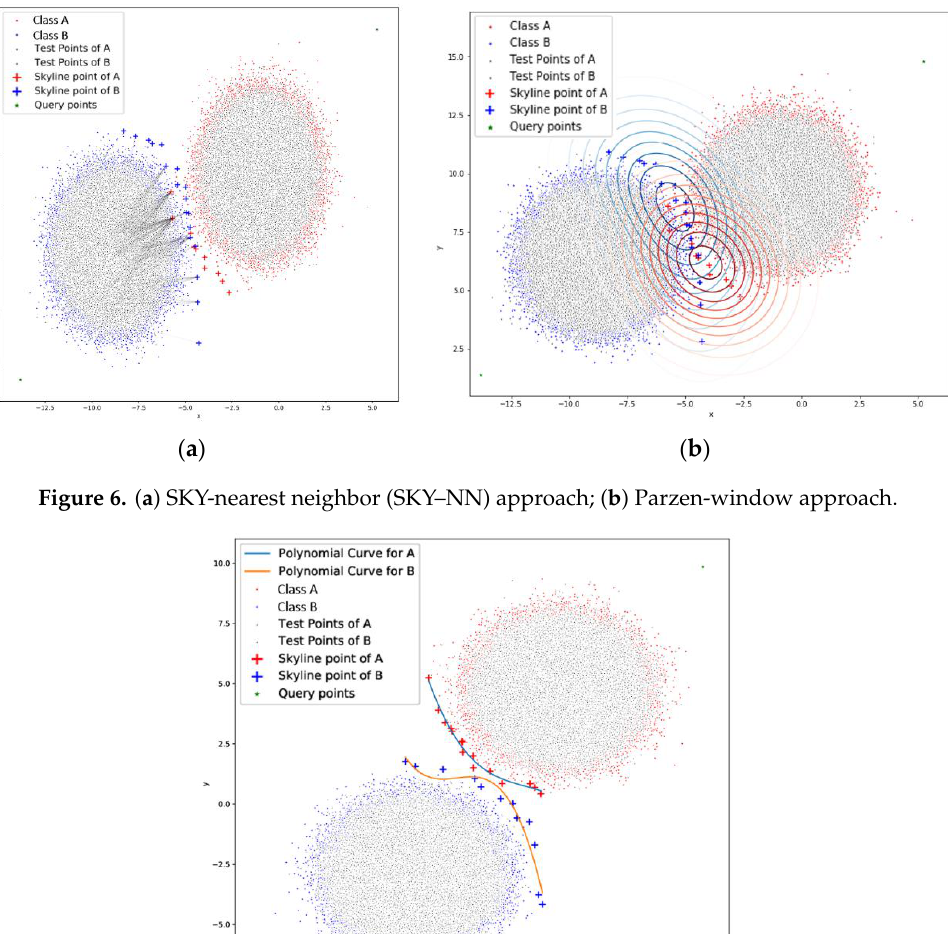
Figure 7. Polynomial curve-fitting approach.